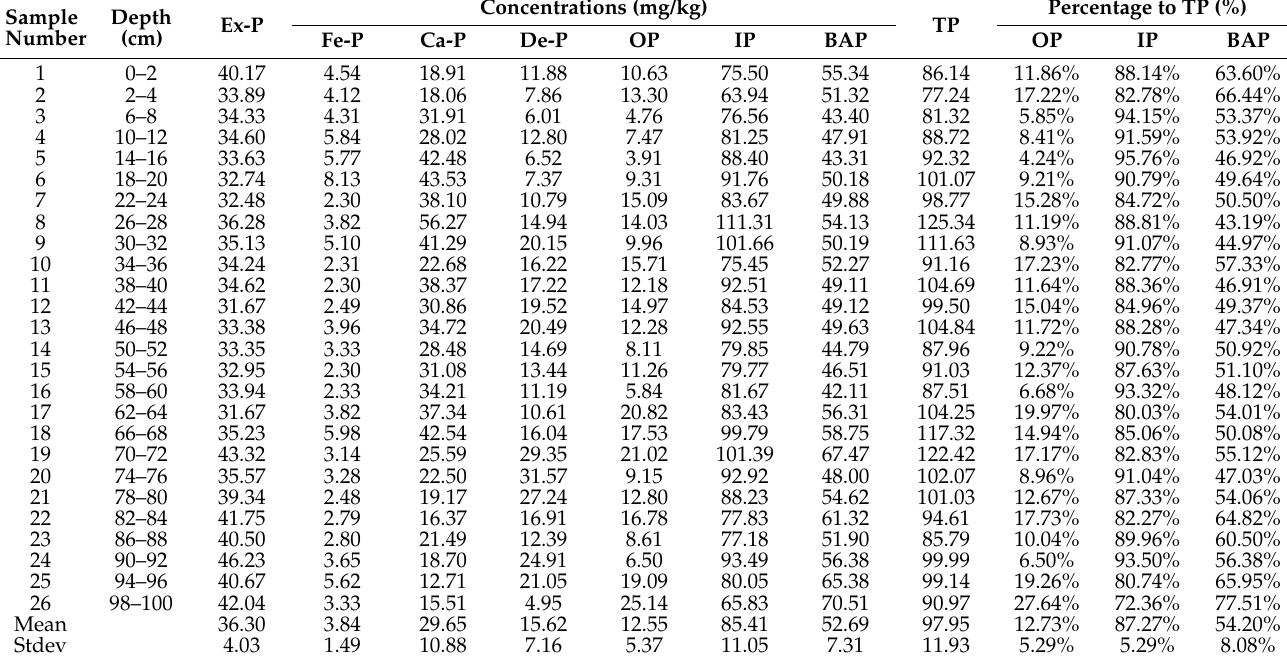
Table A3. Sampling site